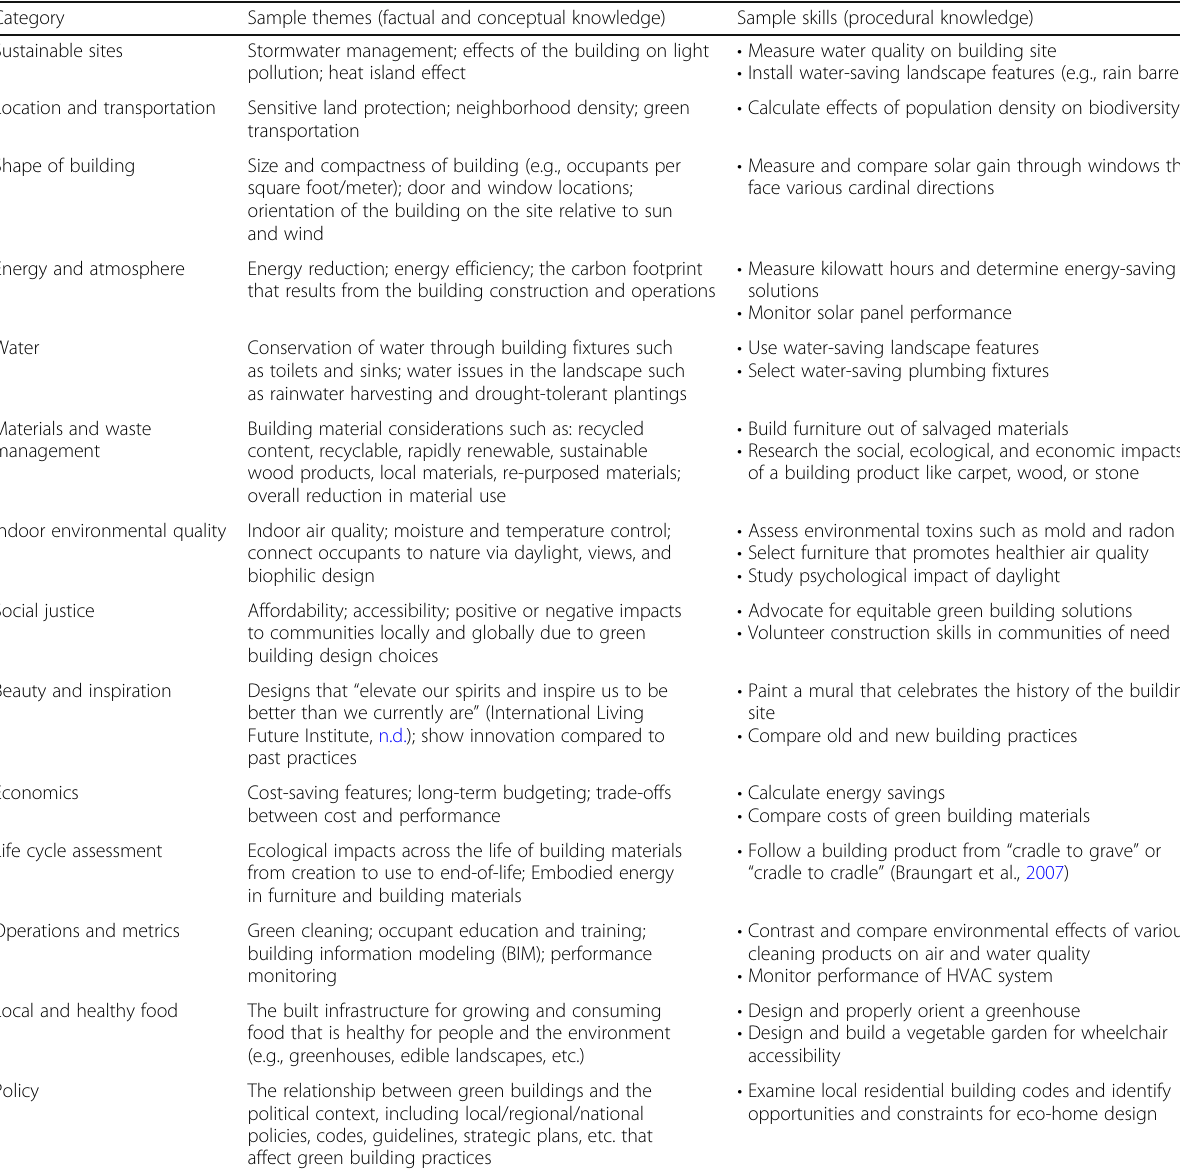
Table 2 Green building knowledge categories Category Sample themes (factual and conceptual knowledge) Sample skills (procedural